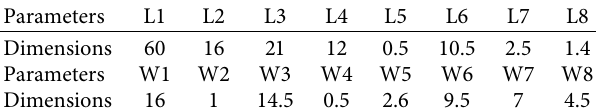
Figure 1: (a) Configuration parameters of the four-port antenna. (b) Configuration with corresponding lumped elements. Table 1: Optimal physical dimensions of the MIMO antenna.